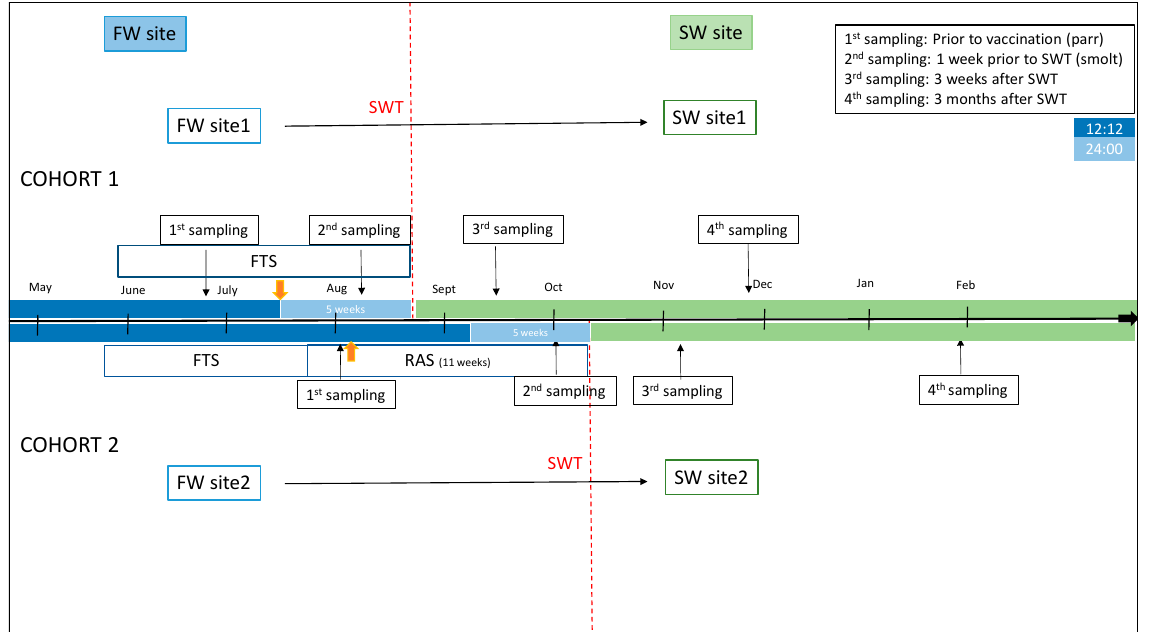
Figure 1. Production protocols and sampling regime. Cohort 1 consisted of FW site1 and SW site1. Cohort 2 consisted of FW site2 and SW site2. Time-points of samplings and SWT are indicated. Time-points for vaccination are indicated by yellow arrows. Light regimes in freshwater phase are indicated by light blue (24:00) and dark blue (12:12). Freshwater (FW), seawater (SW), seawater transfer (SWT), flowthrough system (FTS), recirculation aquaculture system (RAS).